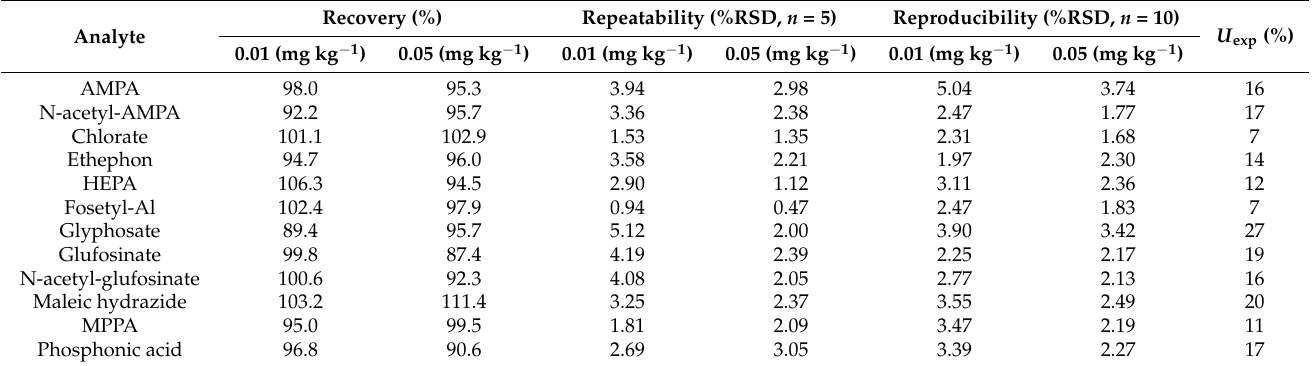
Table 2. Recovery, precision and expanded uncertainty of the highly polar